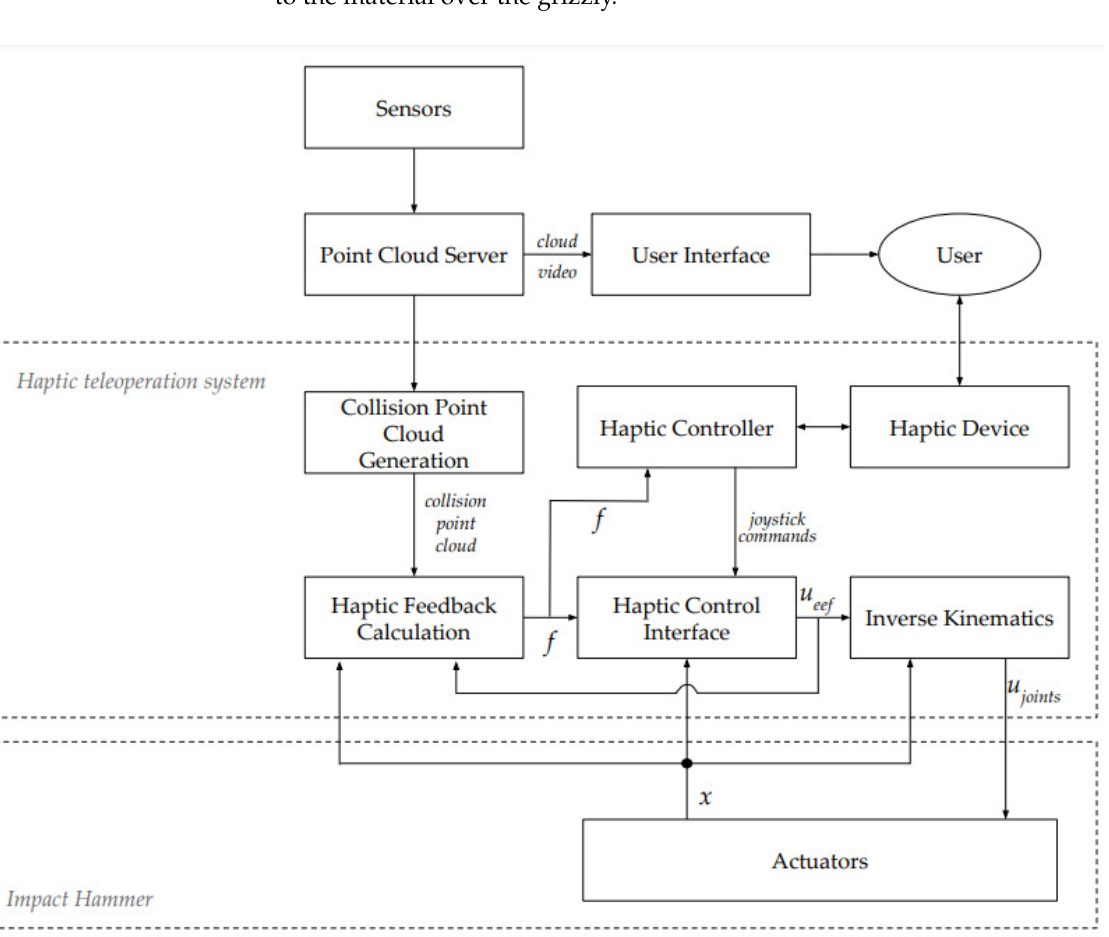
Figure 3. Overall view of the haptic tele-operation framework.